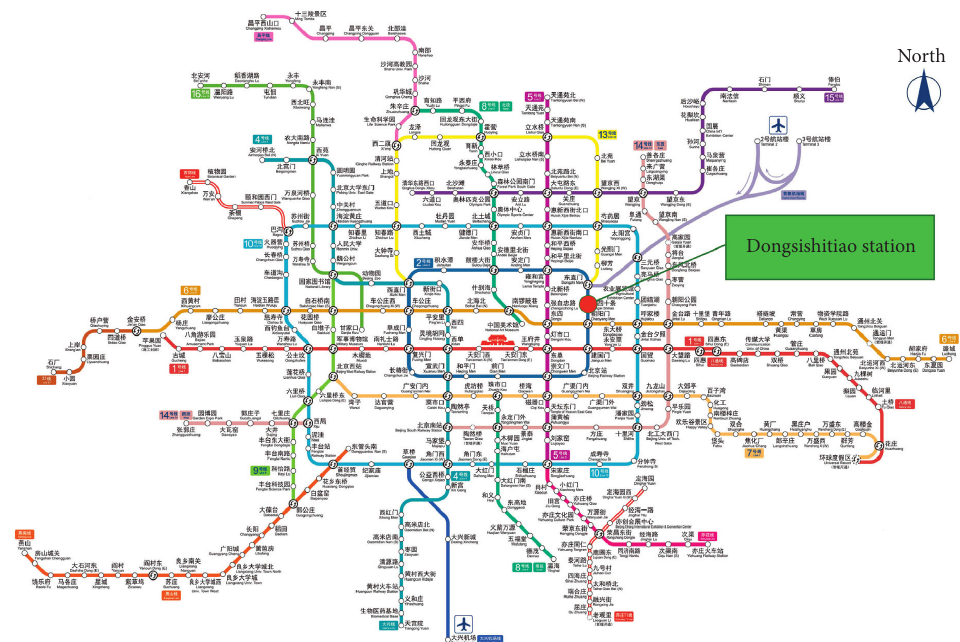
Figure 3: Beijing Subway map. Data source: